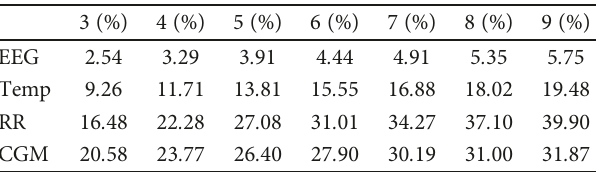
Table 1: Percentage of ties found in the original records of the experimental database, computed as the number of equal values per pattern of length n ∈ 3, 9